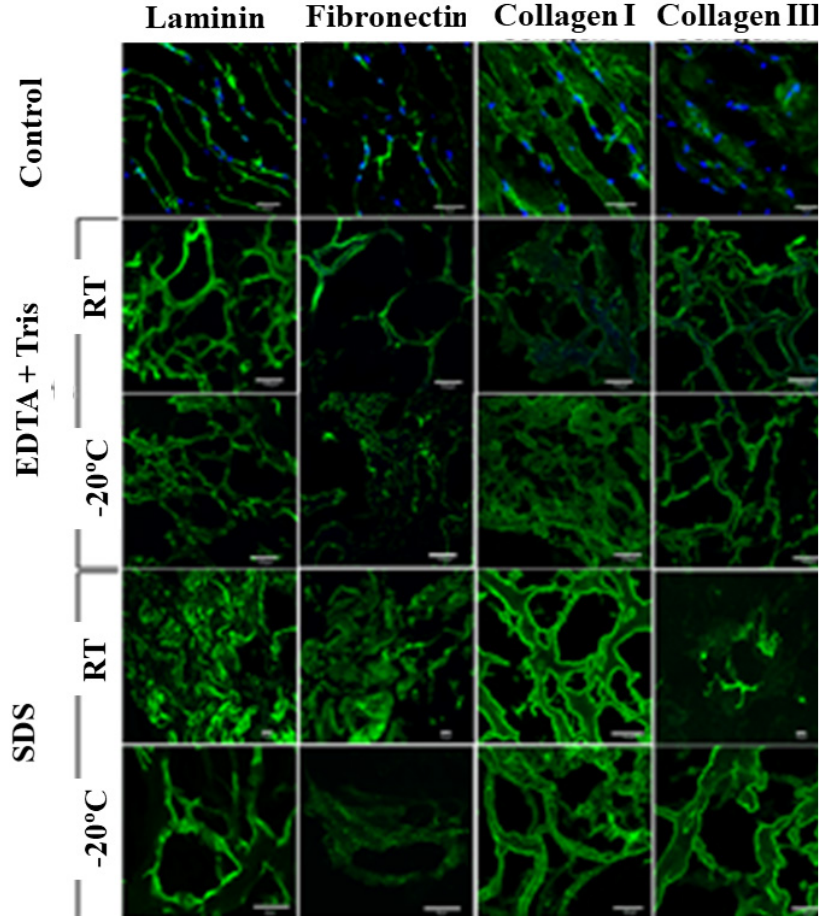
Figure 5. Preservation of cell adhesion (laminin, fibronectin) and structural proteins (collagen types I and III) in the extracellular matrix (ECM) of control and decellularized skeletal muscles of rats analyzed by immunofluorescence. Scale bars= 40 and 100